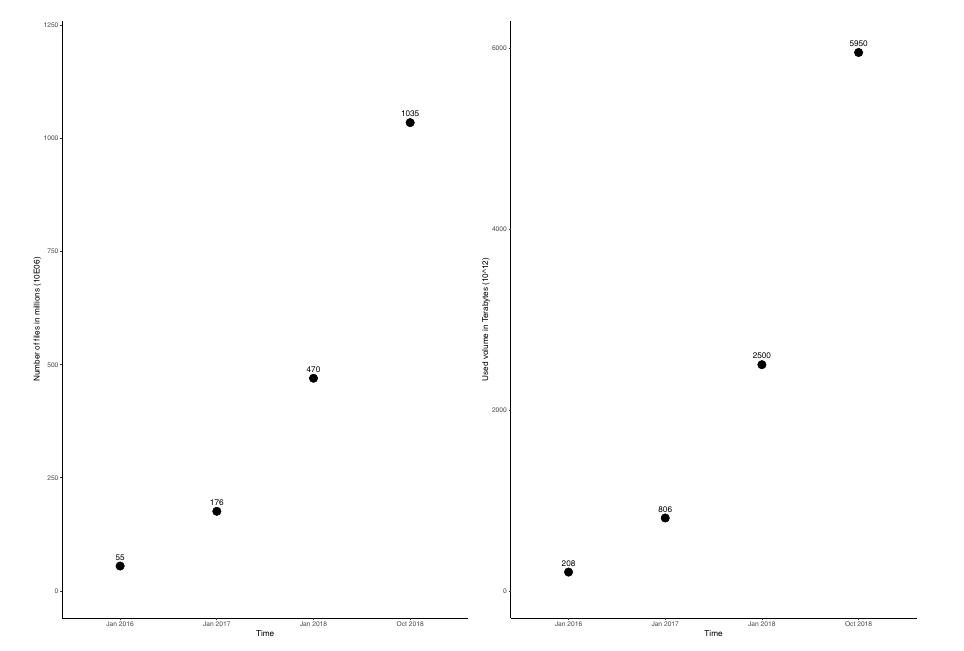
Figure 4. Total number of files by year Figure 5. Total used raw volume by